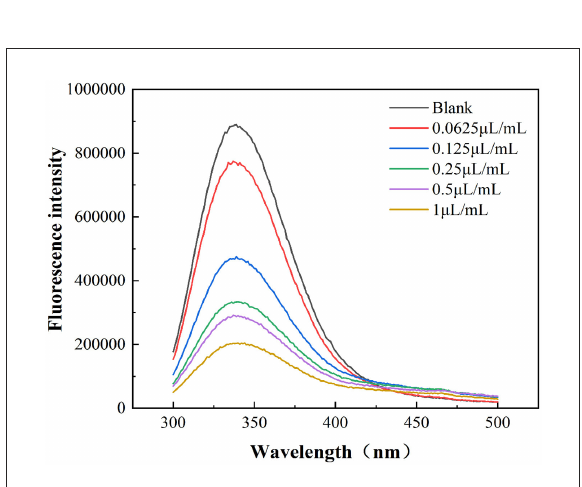
FIGURE5 Fluorescence emission spectra of E. coli treated by different concentrations of cinnamaldehyde.